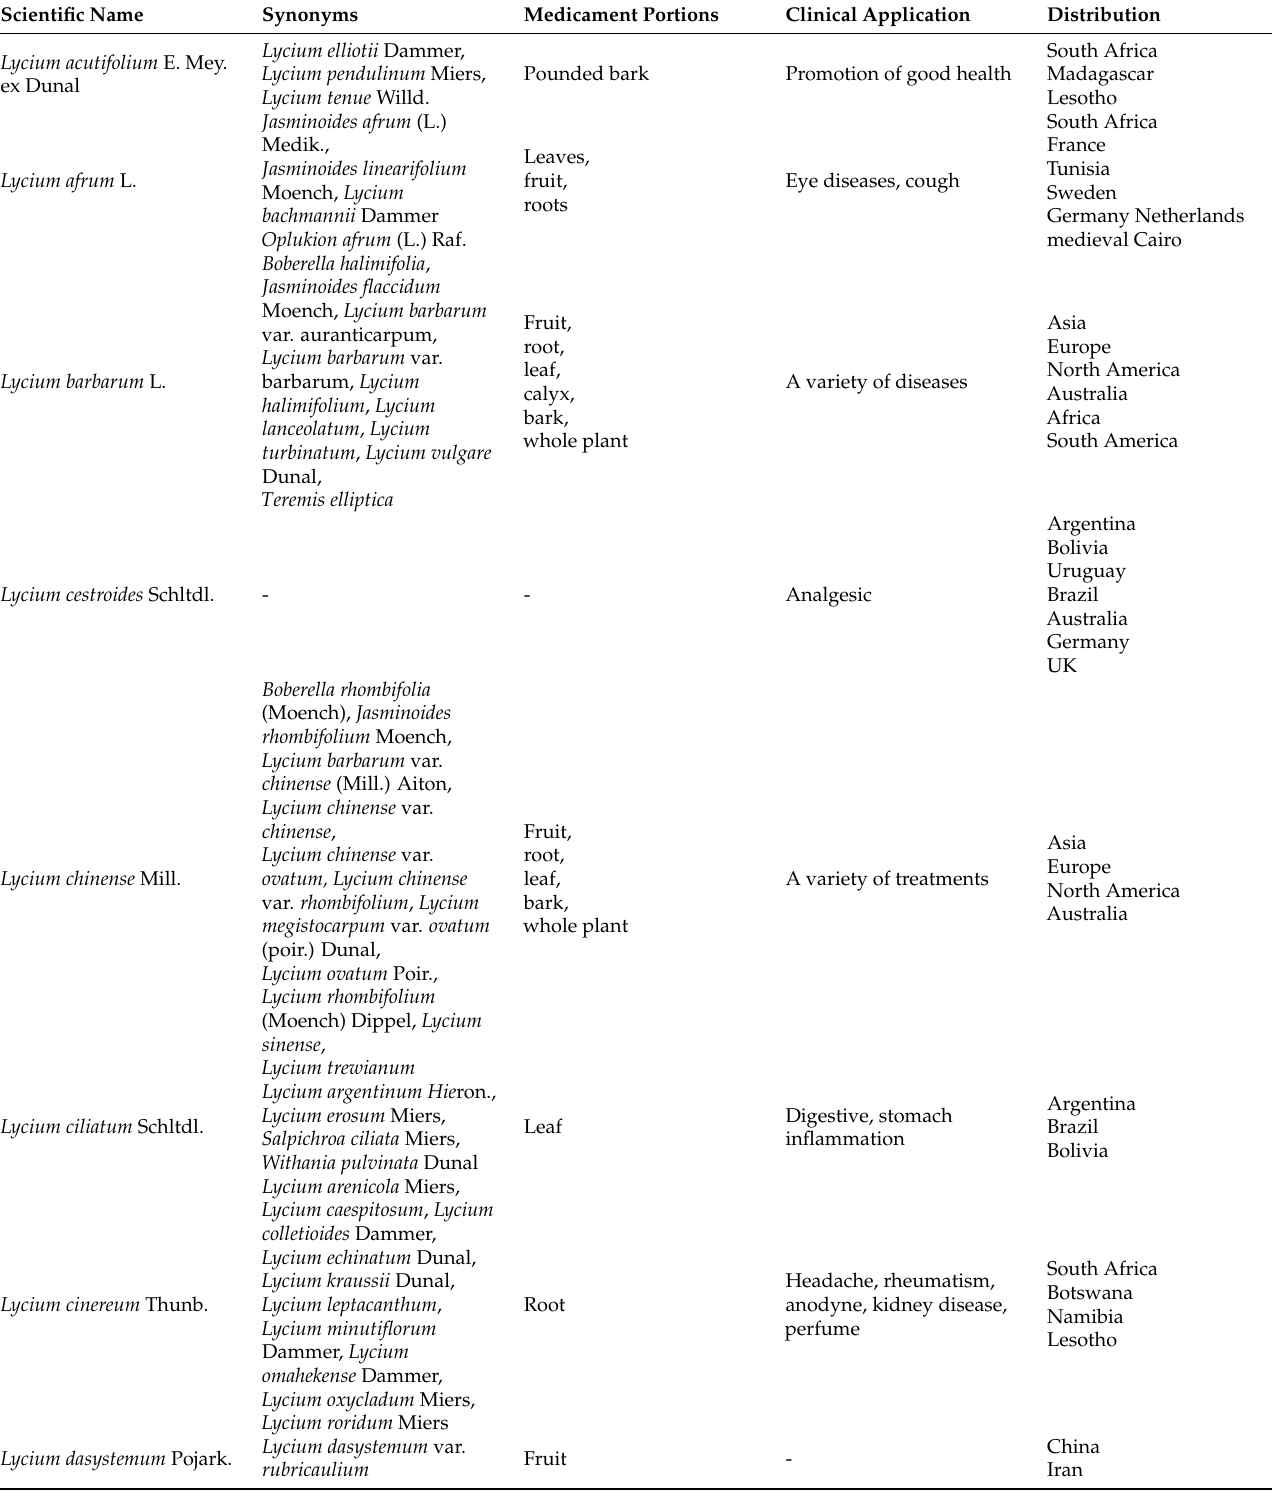
Table 2. Characteristics and distribution of Lycium L. from different